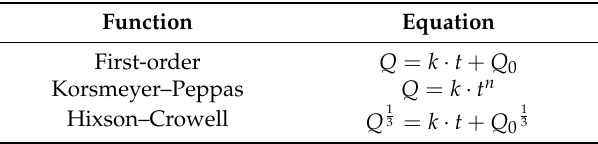
Table 4. Employed mathematical